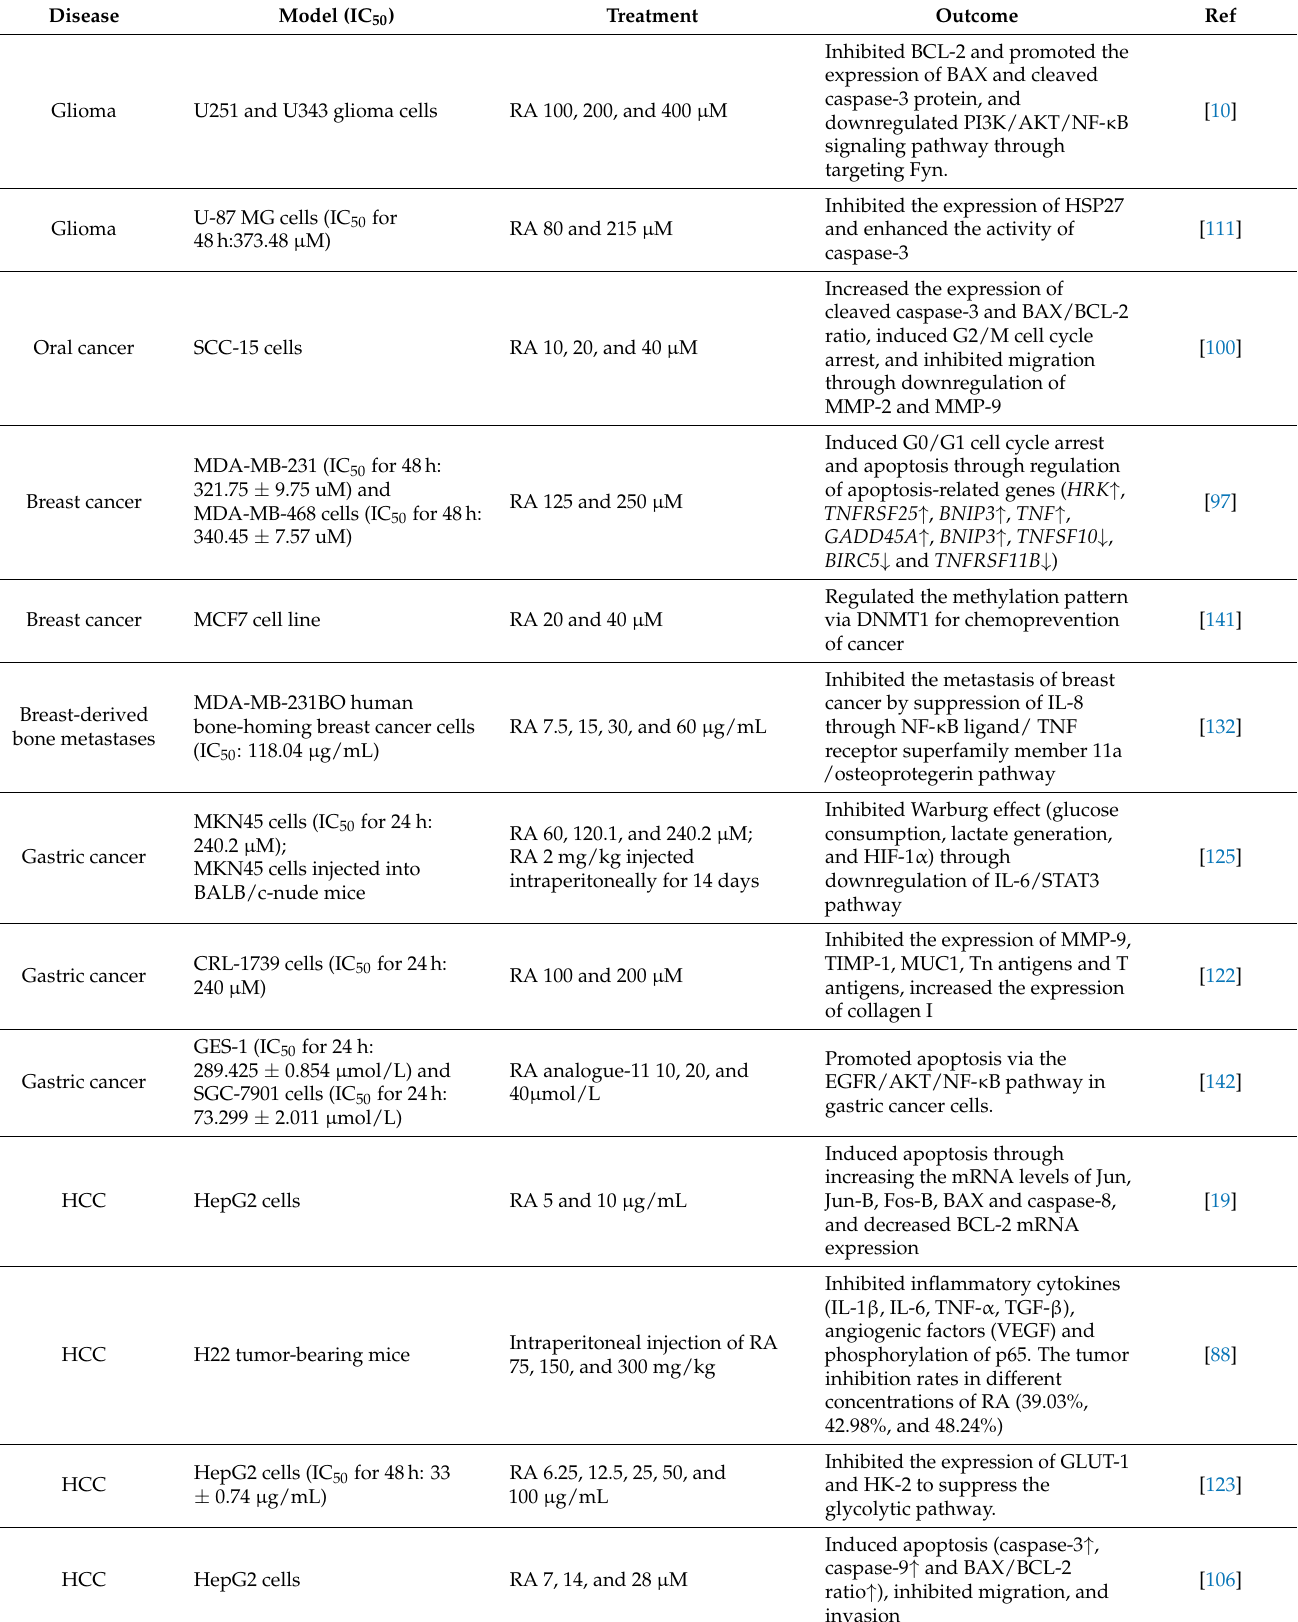
Table 3. Summary of anti-tumor effects of